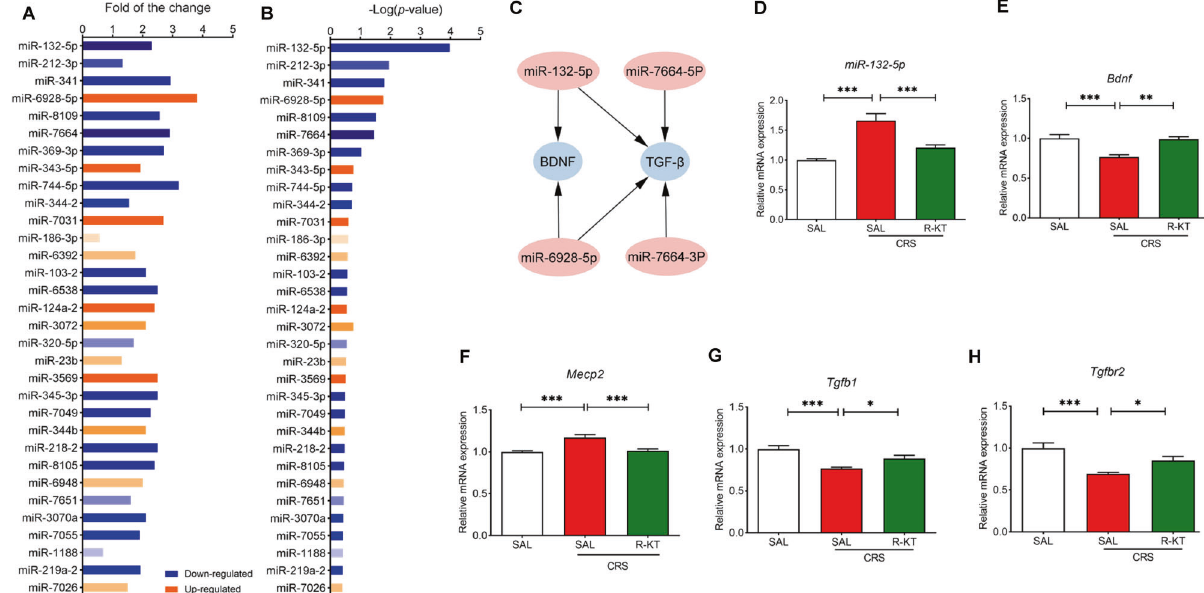
Fig. 2 List of miRNAs and prophylactic effects of ( R )-ketamine on miR-132-5p and related genes in the PFC from CRS mice. A , B RNA- sequence analysis of the prefrontal cortex (PFC) of CRS-exposed mice treated with ( R )-ketamine (10 mg/kg) ( n = 5) or saline ( n = 5). The differentially expressed miRNAs were shown in the ( A : fold of the change) and ( B : P value). C Bioinformatics prediction by TargetScanMouse showed that miR-132-5p can regulate BDNF and TGF- β 1. D Expression of miR-132-5p in the PFC (one way ANOVA: F 2,28 = 19.27, P < 0.0001). E Bdnf mRNA in the PFC (one way ANOVA: F 2,28 = 13.34, P < 0.0001). F Mecp2 mRNA in the PFC (one way ANOVA: F 2,28 = 14.47, P < 0.0001). G Tgfb1 mRNA in the PFC (one way ANOVA: F 2,28 = 13.49, P < 0.0001). H Tgfbr2 mRNA in the PFC (one way ANOVA: F 2,28 = 12.14, P = 0.0002). The data represent mean ± SEM ( n = 10 or 11). * P < 0.05, ** P < 0.01, *** P <